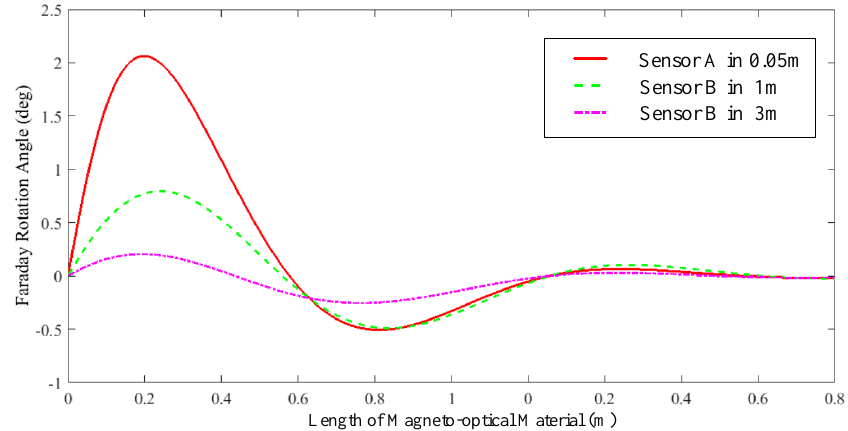
Figure 6. Relationship between the Faraday rotation angle and sensing material size.